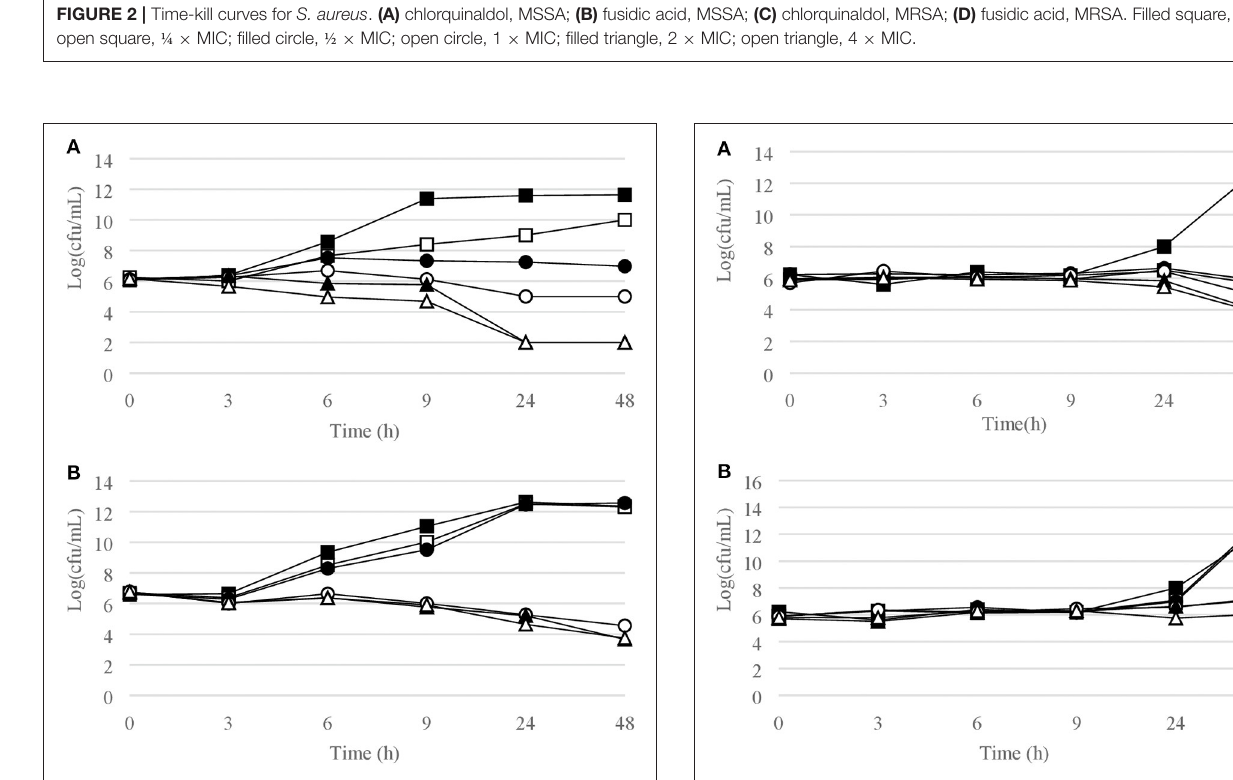
failure. In this background, alternative treatments for patients infected with bacteria resistant to conventional antimicrobials are urgently required. Some possibilities